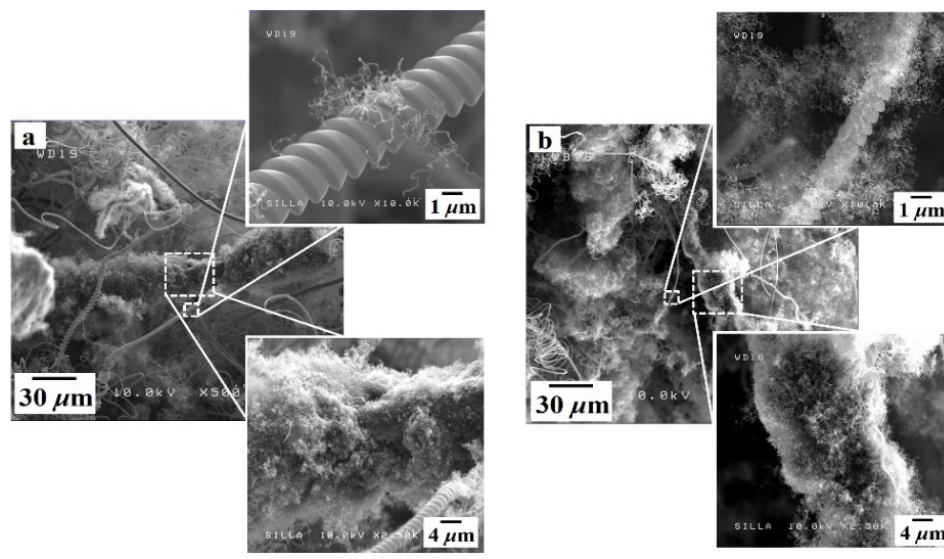
Figure 9. FESEM images of samples ( a ) G and ( b ) H.